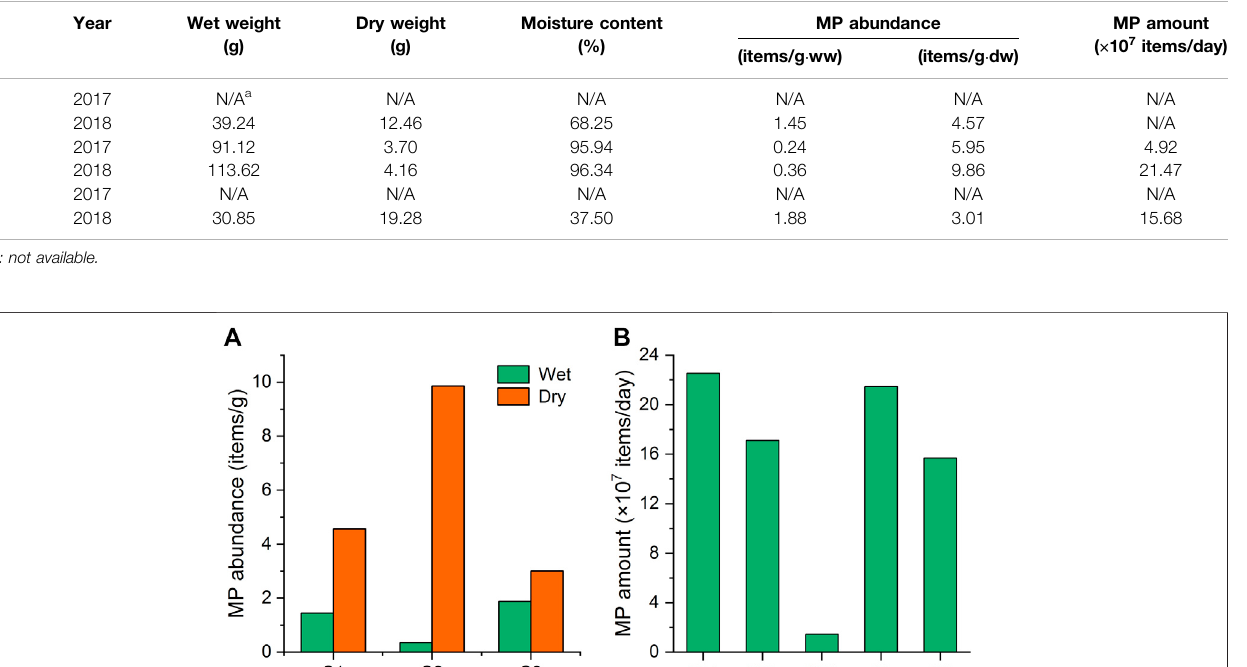
TABLE 3 | The characteristics of sludgy samples.